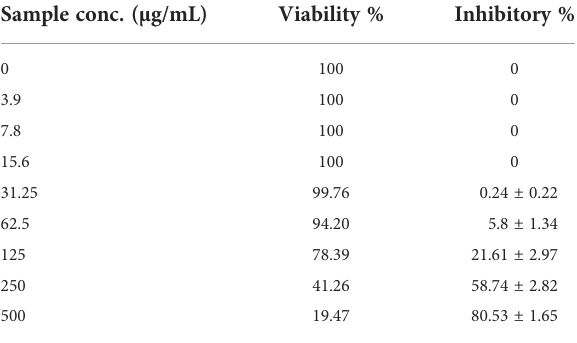
TABLE 2 The Cytotoxic activity against Mammalian cells from African Green Monkey Kidney (Vero) with 50% cell cytotoxic concentration (CC 50 ) = 220.53 ± 6.89 µg/ml.